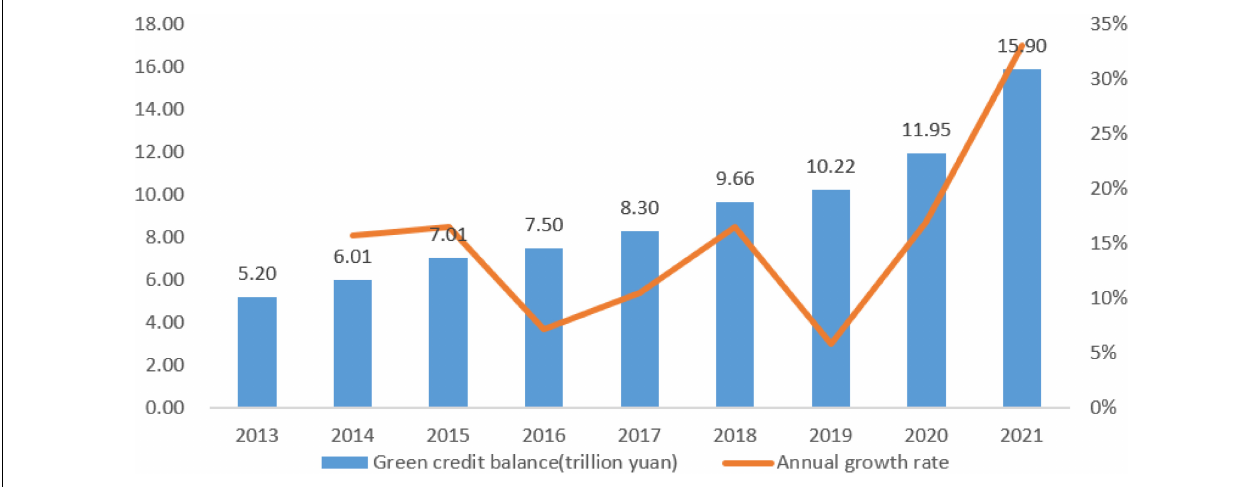
FIGURE 1 | Balance and annual growth rate of green credit in domestic and foreign currencies of major financial institutions in China,